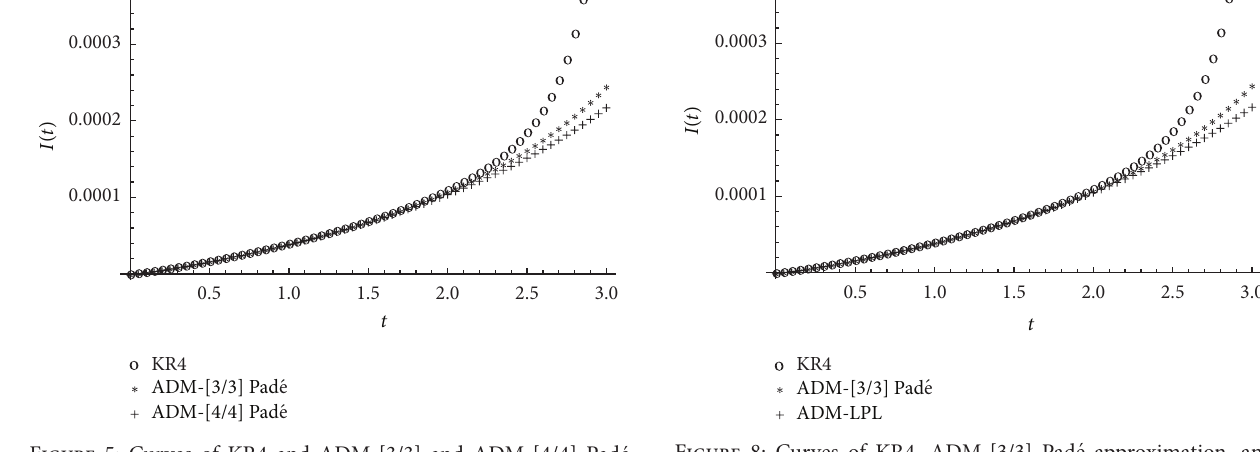
Figure 5: Curves of KR4 and ADM-[3/3] and ADM-[4/4] Pad´e approximations for 𝐼(𝑡) .